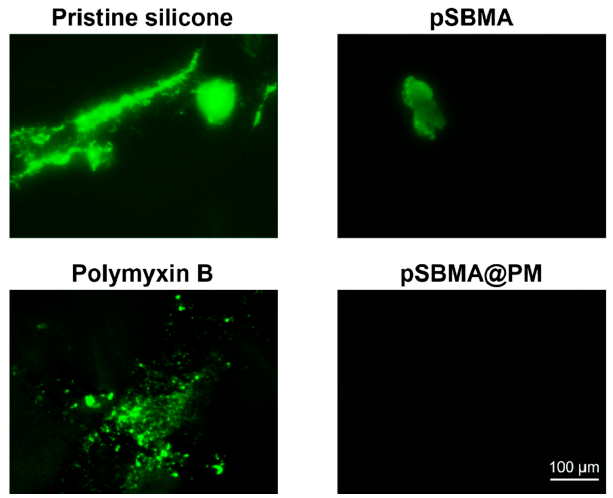
Figure 2 . Fluorescence images taken after 30 min of incubation in 1 mg mL − 1 of FITC-labeled BSA solution.